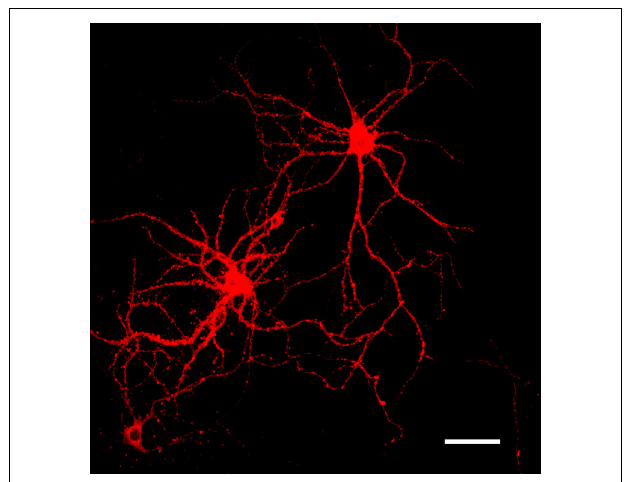
FIGURE 3 | Representative images of DiI labeled neurons. DiI highlighting the dendritic complexity and topographical connectivity of neurons. Dendritic arbors and spines are sufficiently filled and visualized in their entirety with the fluorescent dye. Scale bar = 50 μ m.